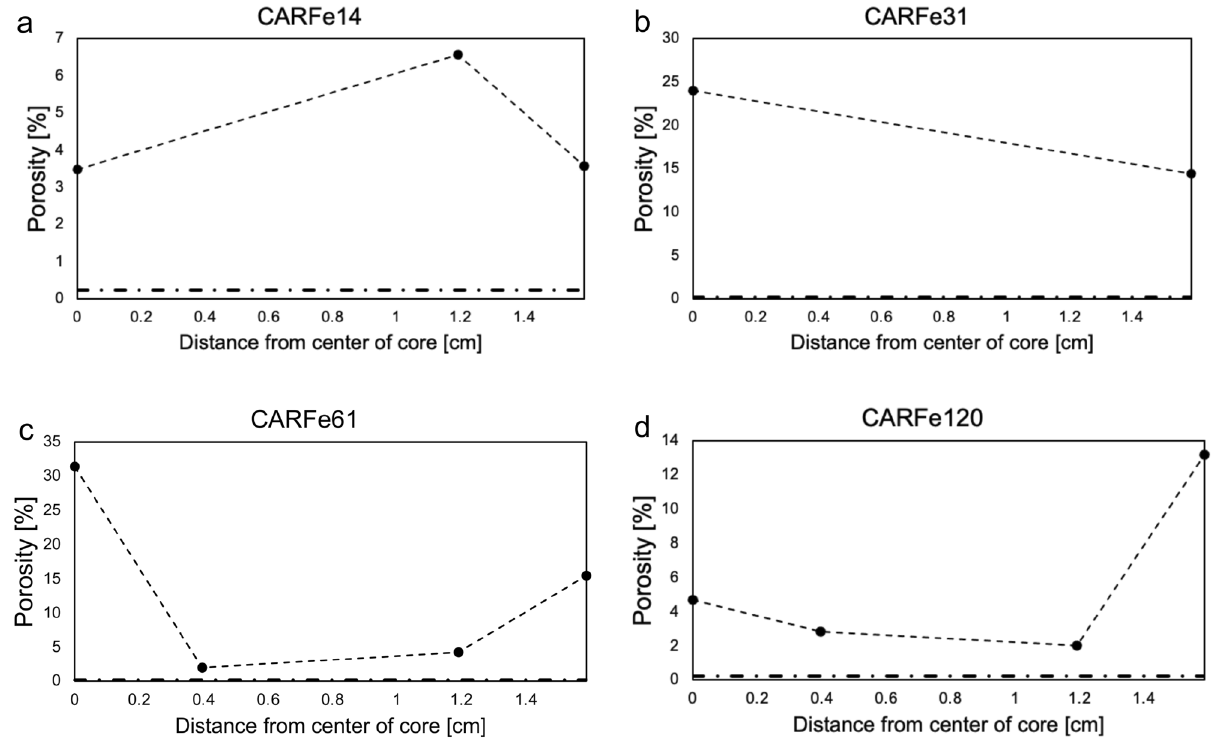
Figure 6. (U)SANS results for CAR. Porosity is plotted as a function of distance from center of the rock core for ( a ) CARFe14, ( b ) CARFe31, ( c ) CARFe61 and ( d ) CARFe120. Horizontal dashed-dotted line indicates porosity in pristine CAR marble